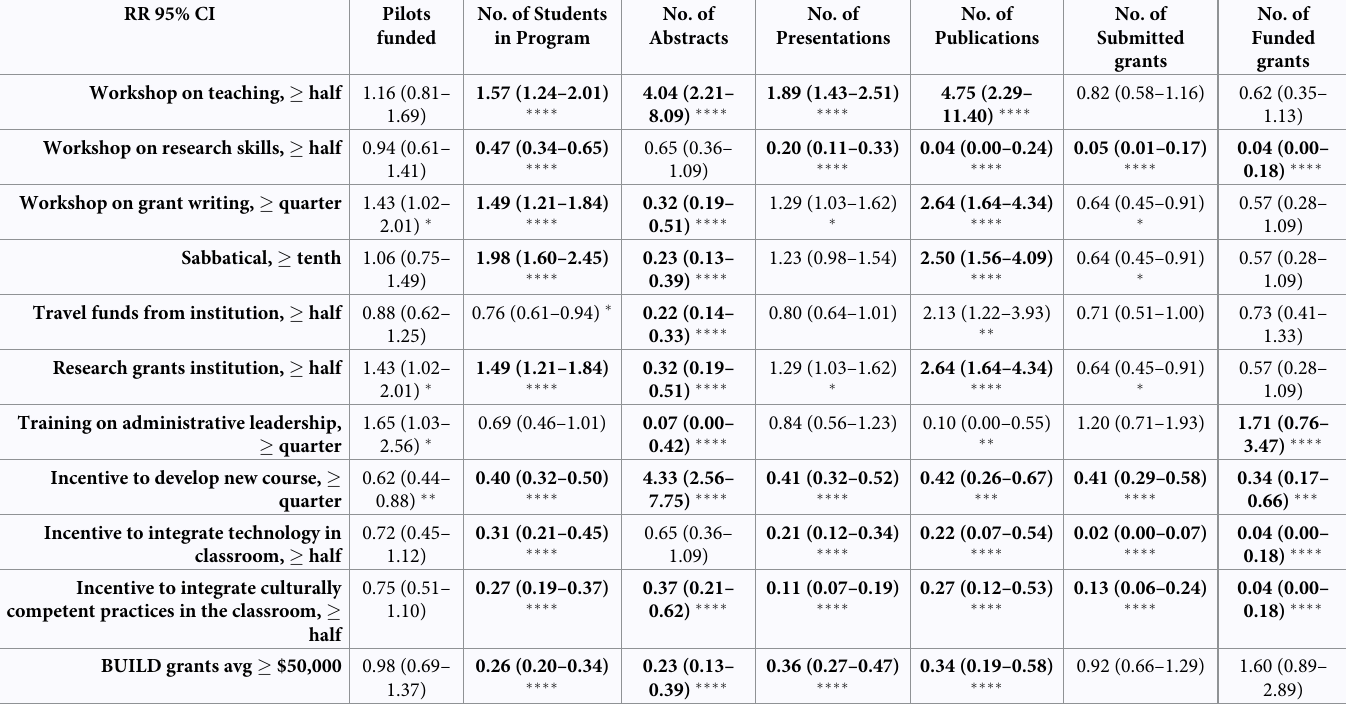
Table 5. Rate ratio of increased productivity for institutions based on annual progress reports in 2015–2018 to participants’ use of a tool as indicated by the 2016– 2017 HERI